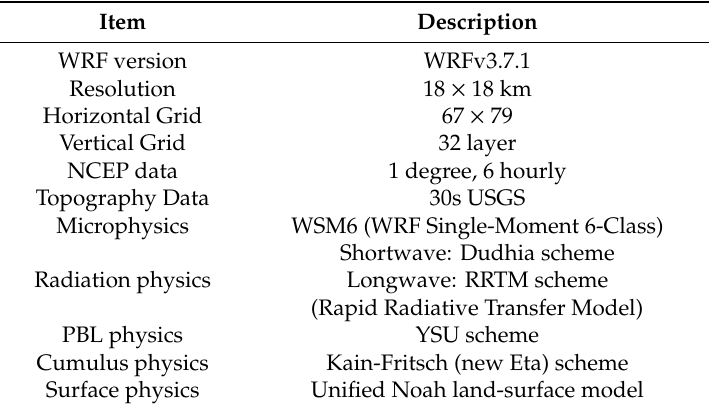
Table 6. Meteorology model configuration